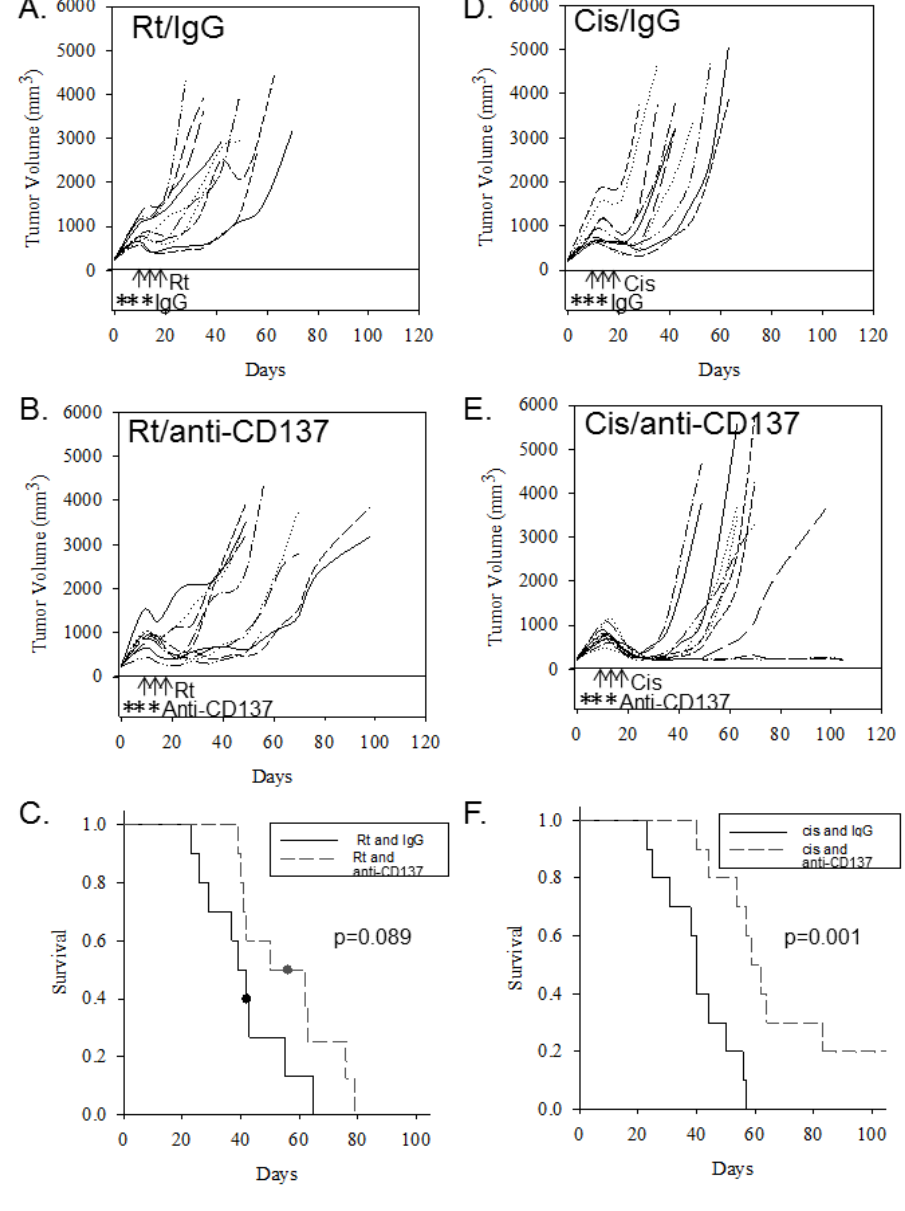
Figure 2. Administration of activating anti-CD137 antibody preferentially enhances the effects of cisplatin treatment. Tumor growth curves (for individual mice) and group Kaplan-Meyer survival curves are shown for mice receiving cisplatin or radiation with IgG, and for mice receiving cisplatin or radiation in conjunction with activating anti-CD137 antibody. ( A ) Growth curves of mice receiving three doses of radiation (8 Gy, on indicated days, arrows) and control IgG (on indicated days, asterisks); ( B ) Growth curves of mice receiving three doses of radiation (arrows) and anti-CD137 antibody (asterisks); ( C ) Kaplan-Meyer survival plot comparing mice in A and B; ( D ) Growth curves of mice receiving three doses of cisplatin (20 mg/kg, on indicated days, arrows) and control IgG (on indicated days, asterisks); (E ) Growth curves of mice receiving cisplatin (arrows) together with anti-CD137 antibody (asterisks); ( F ) Kaplan-Meyer survival plots of groups in D and